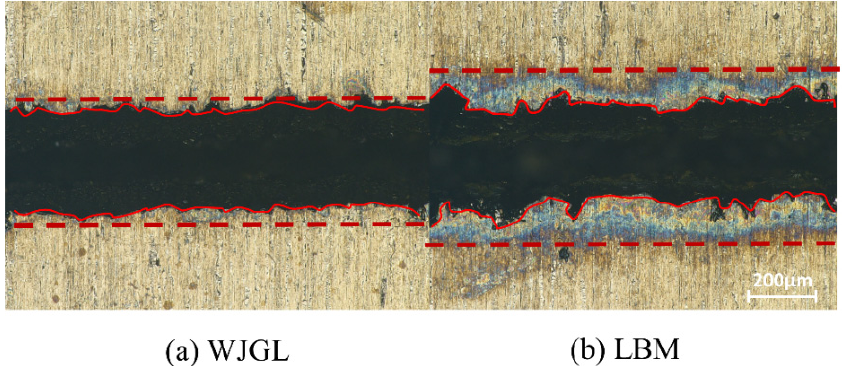
Figure 18. The results of predicted values and experimental results.